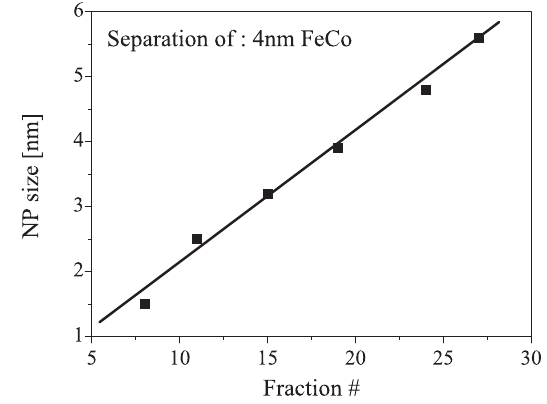
Fig. 3 The average particle size as functions of fraction num- bers for FeCo NPs (Figure was taken from Fig. S2 in Supporting Information of the literature (Sun X. et al.,